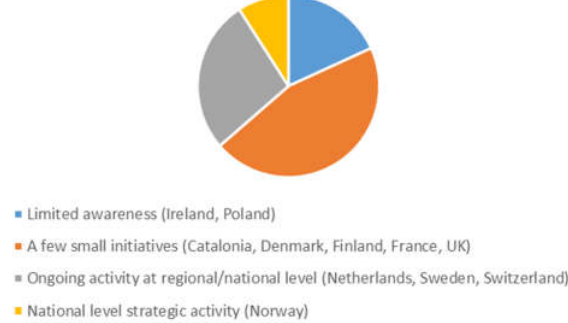
Figure 3 - Level of GeoBIM Expertise within the